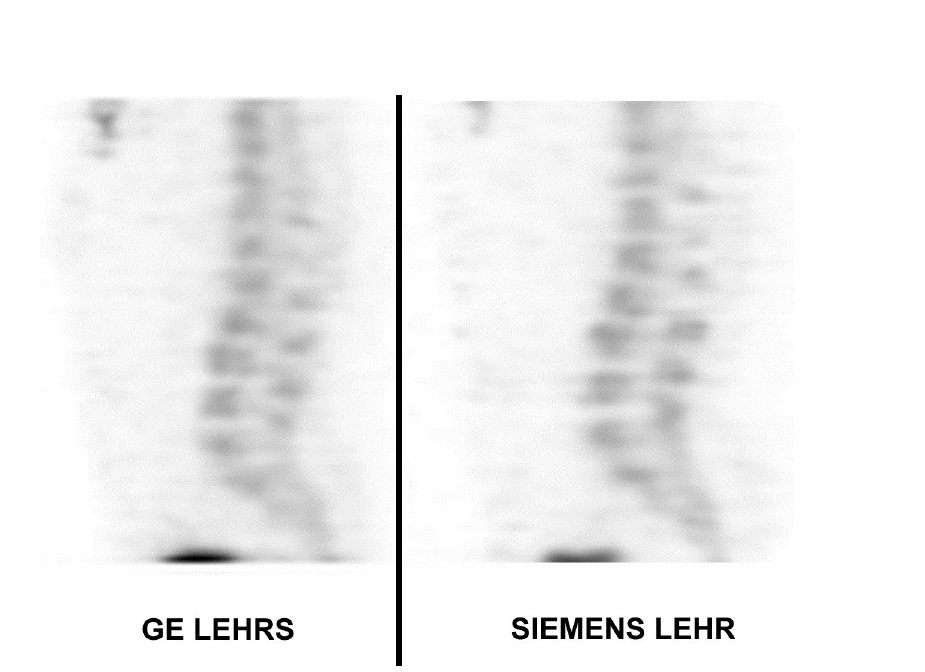
Fig 8. Lumbar SPECT. No difference in image quality was noticed between the two systems.